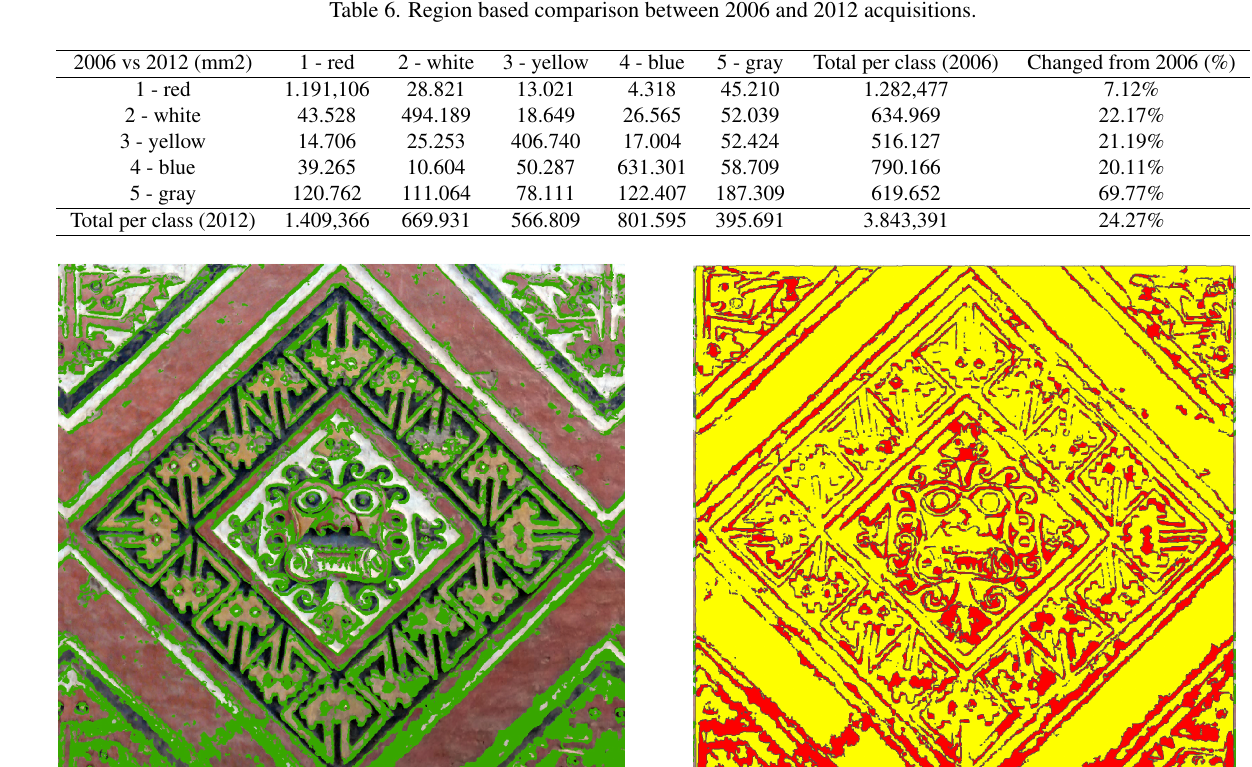
Table 6. Region based comparison between 2006 and 2012 acquisitions.